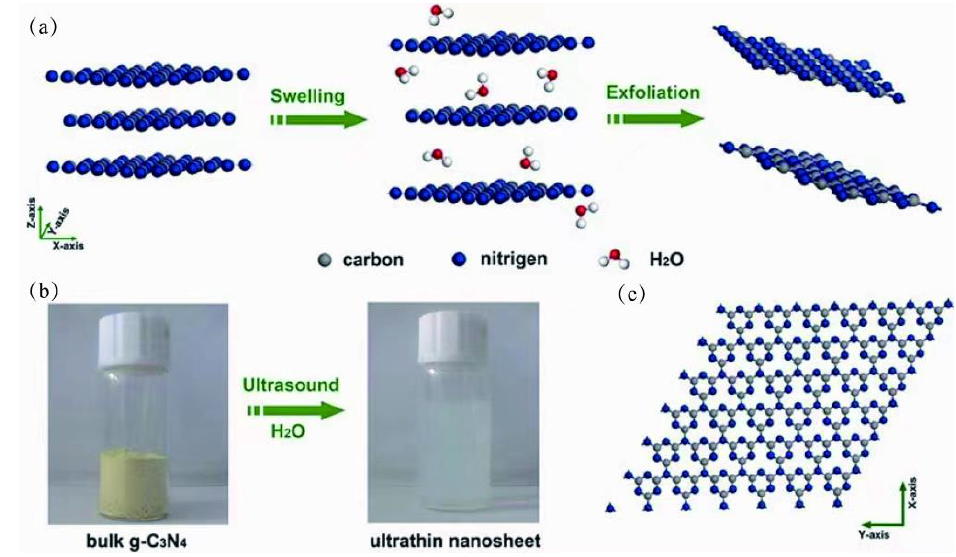
Figure 4. ( a - c )Schematic illustration for the liquid-exfoliation process of bulk g − C 3 N 4 [84]. Copyright 2012, American Chemical Society.